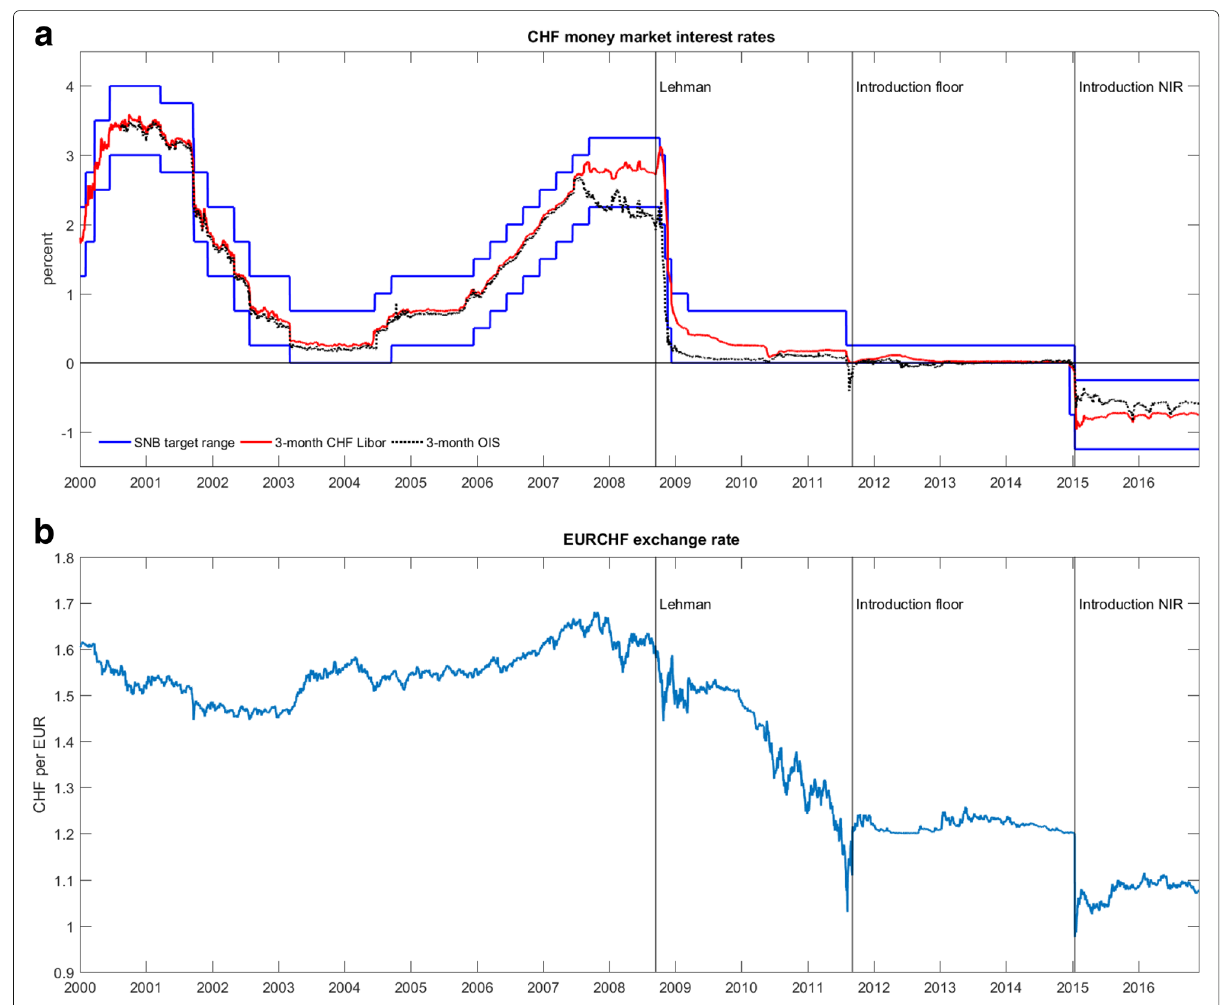
Fig. 1 a , b CHF money market rates and EURCHF exchange rate